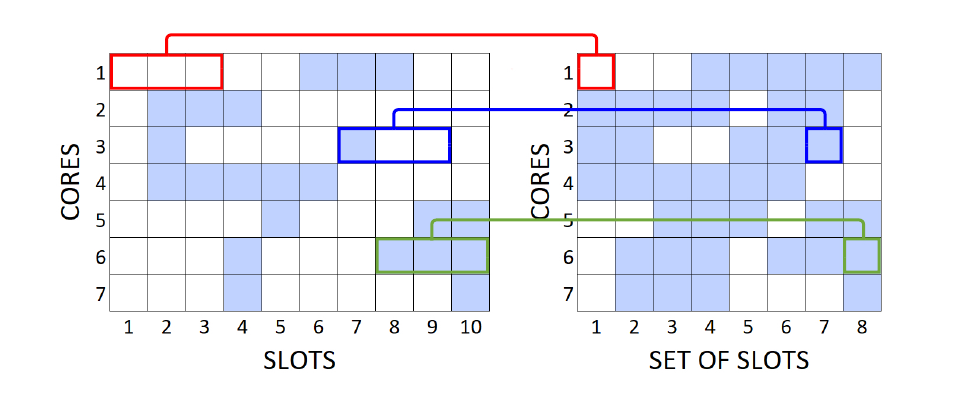
Figure 1. Spectrum Matrix and Mapped Matrix.